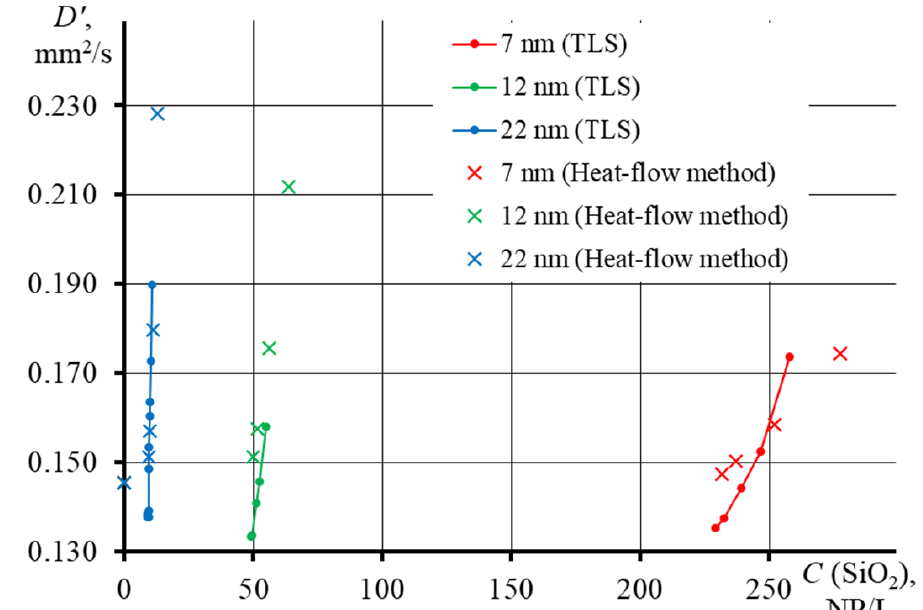
Figure 10. Effect of particle concentration on thermal diffusivity of dispersions for different Ludox series (SM, d av = 7 nm; HS, d av = 12 nm; TM, d av = 22 nm), where crosses are heat flow measurements, Equation (14) and lines are TLS measurements, Equations (10) and (2).